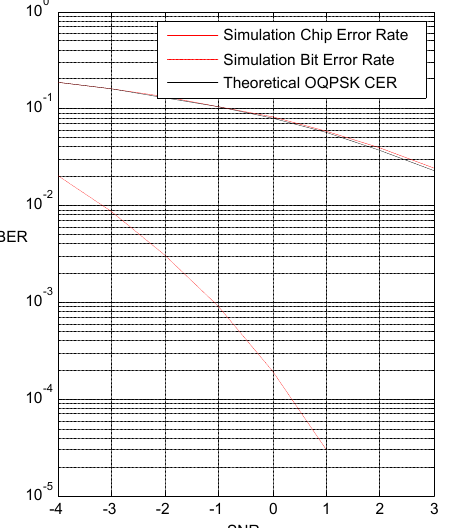
Simulation Chip Error Rate Simulation Bit Error Rate Theoretical OQPSK